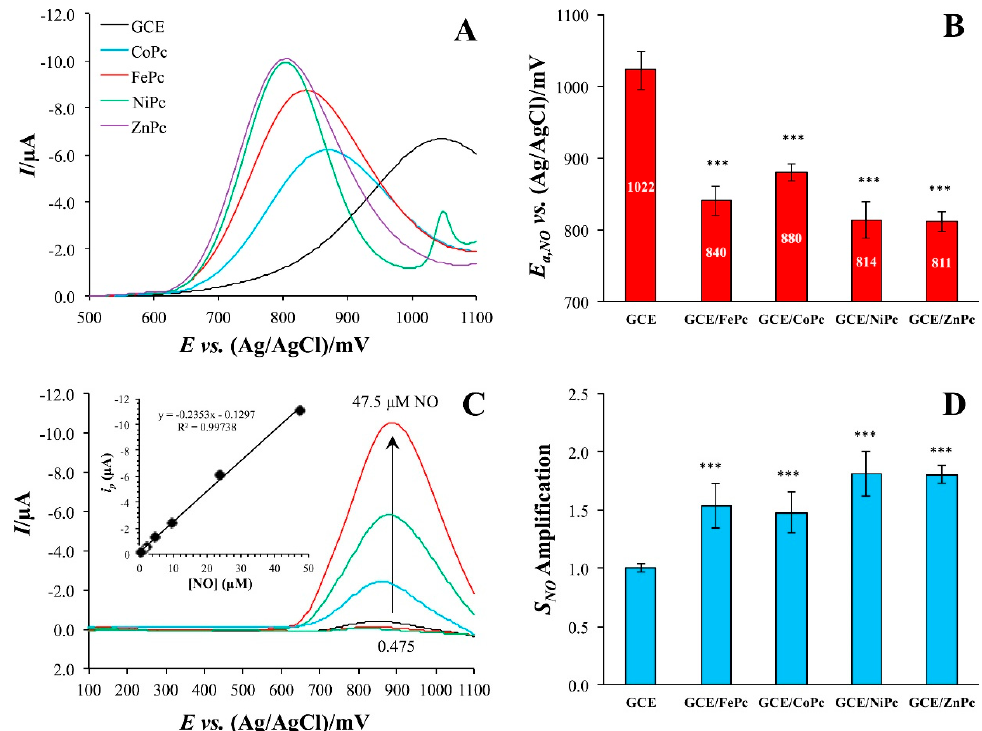
Figure 2. ( A ) Differential pulse voltammograms of bare and MPc-modified GC electrodes in the presence of 23.75 μ M NO in pH 7.4 PBS with ( B ) corresponding peak potentials. ( C ) Overlay of DPV traces collected in the presence of different NO concentrations on a FePc-modified GCE (Inset: calibration curve from the peak currents as a function of concentration). ( D ) Nitric oxide sensitivity amplification of MPc-modified electrodes relative to the bare GCE. *** = p < 0.001 with respect to GCE. Reprinted with permission from Ref. [47]. Copyright 2018